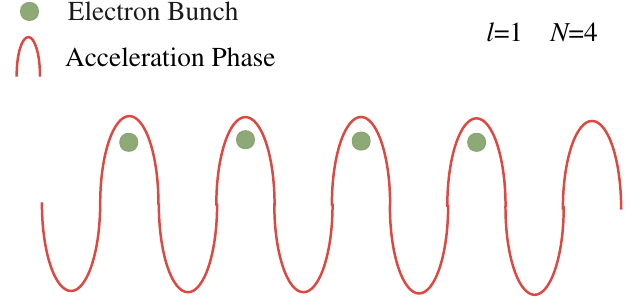
FIG. 7. (Color) The arrangement of multiple bunches operation. In this figure each single bunch is separated by one wavelength and the number of total bunches is taken as 4. The electron bunches are set to be on the peak of acceleration